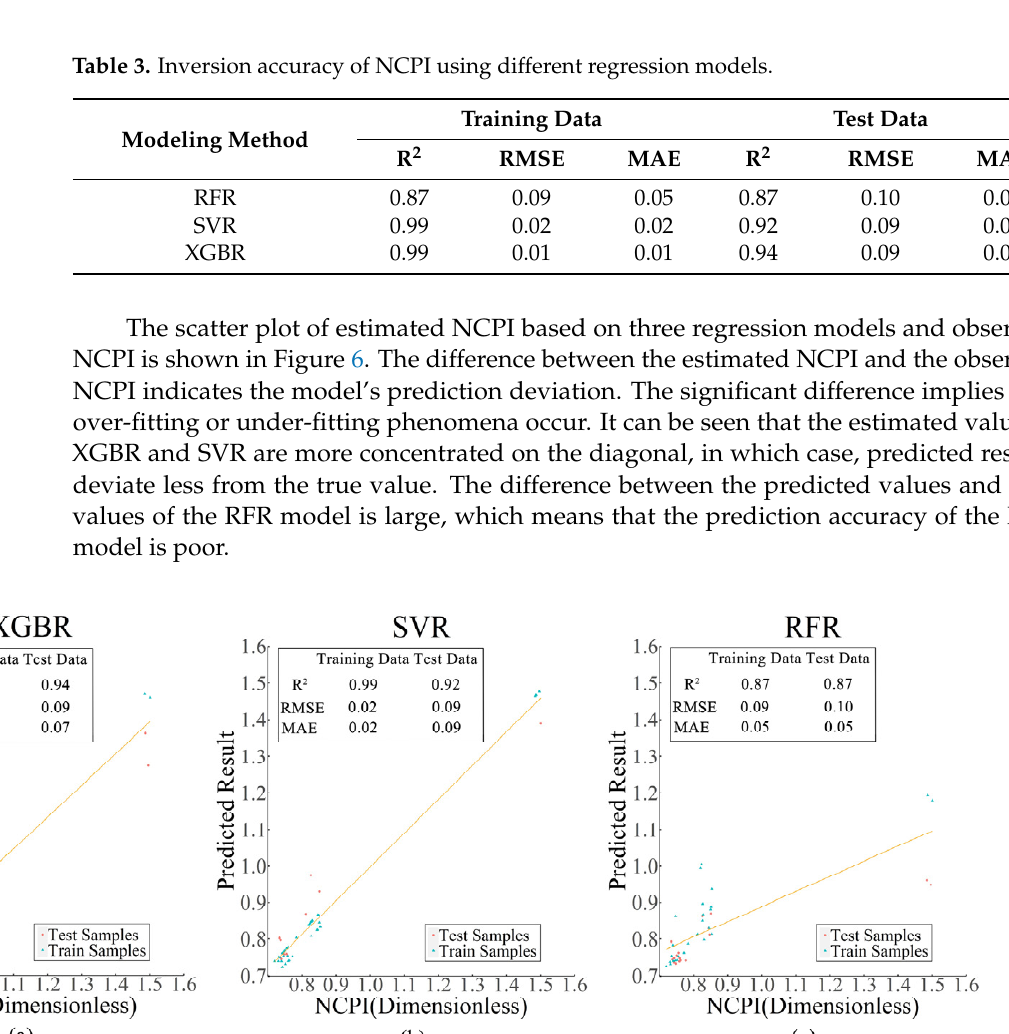
Table 3. Inversion accuracy of NCPI using different regression models.